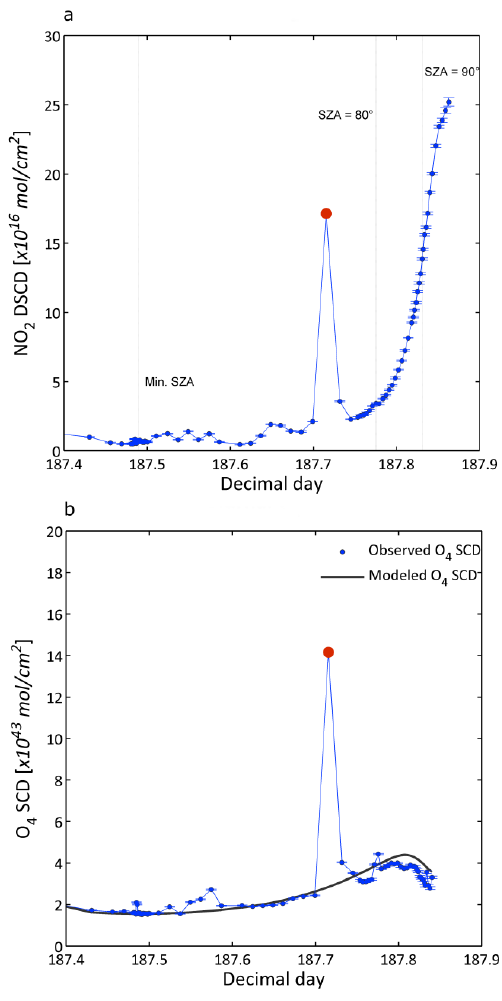
Figure 1. Example of a NO 2 enhancement event, due to multiple scattering, on day 187 (6 July 2009). Both (a) the NO 2 DSCD and (b) the O 4 SCD diurnal cycles show a large spike at approximately 17:10LT (red